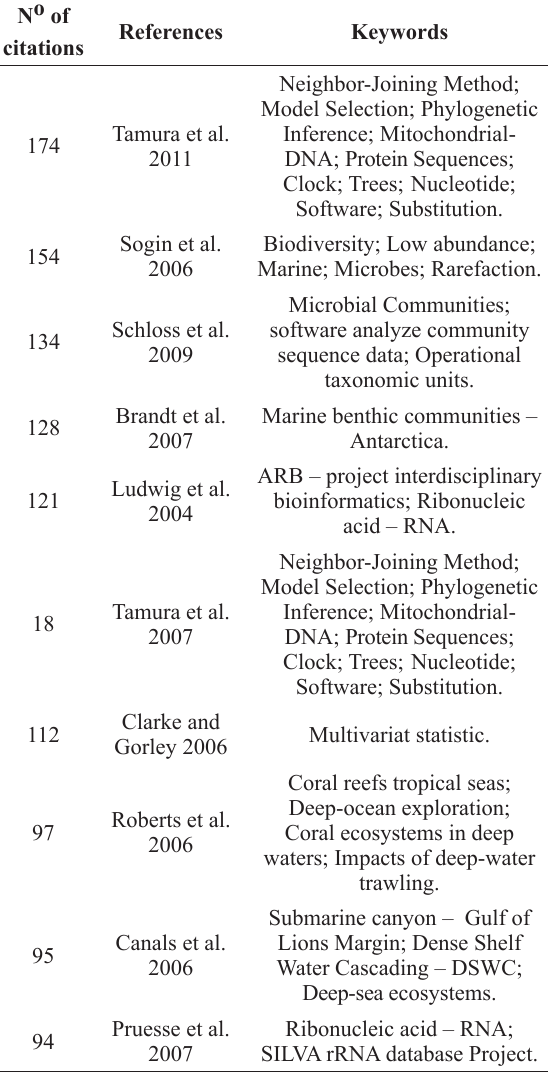
Number of citations and keywords of the 10 most cited articles between 1987 and